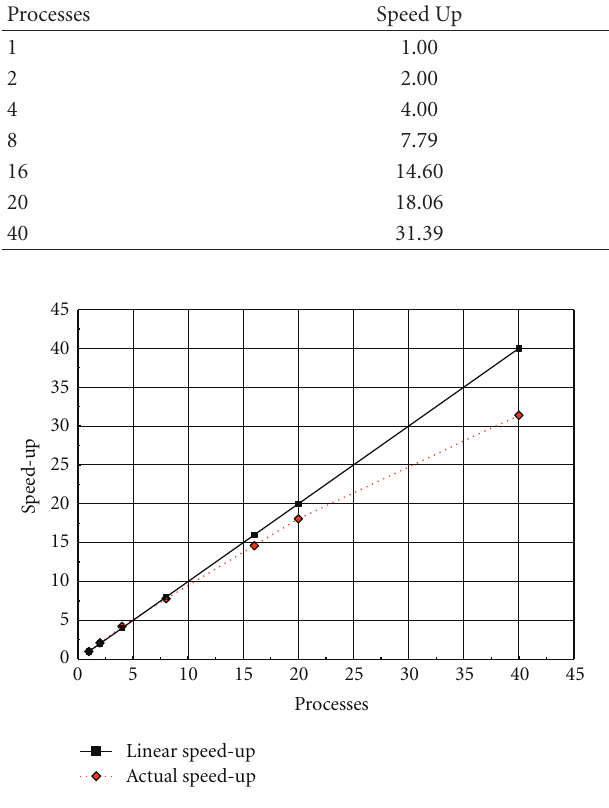
Figure 1: Typical Speed-Up factor as a function of number of